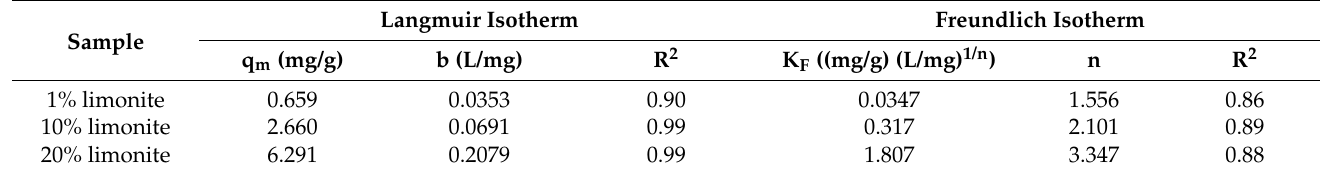
Figure 3. ( a ) Plot of q e vs. C e . Adsorption data fitted with ( b ) linearized Langmuir isotherm, and ( c ) linearized Freundlich isotherm. Table 1. Langmuir and Freundlich adsorption isotherm parameters for the adsorption of MB.